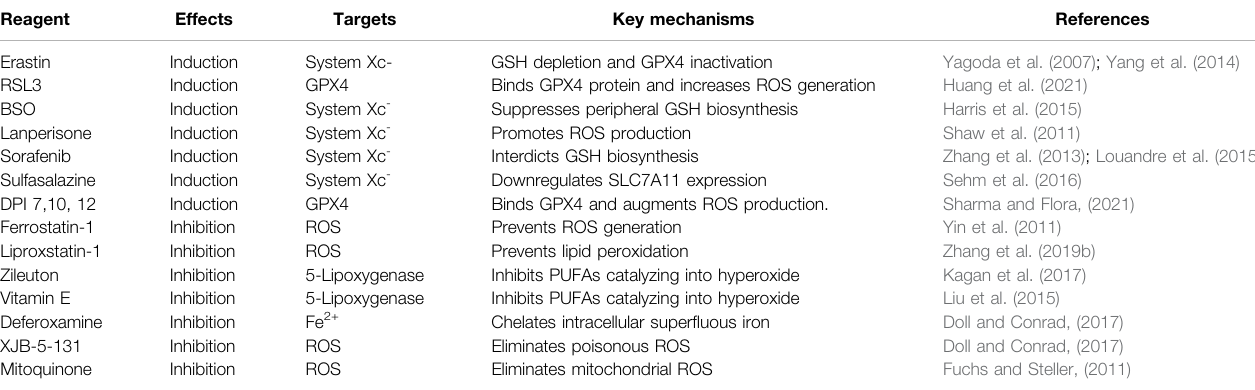
TABLE 2 | Ferroptosis initiators and inhibitors: targeting strategy for